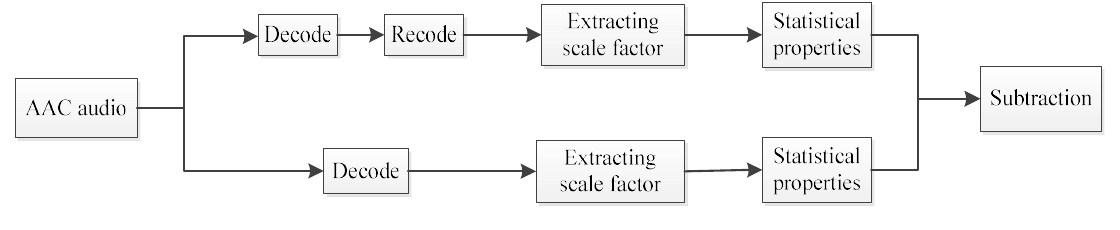
Figure 3. Feature extraction flow chart.